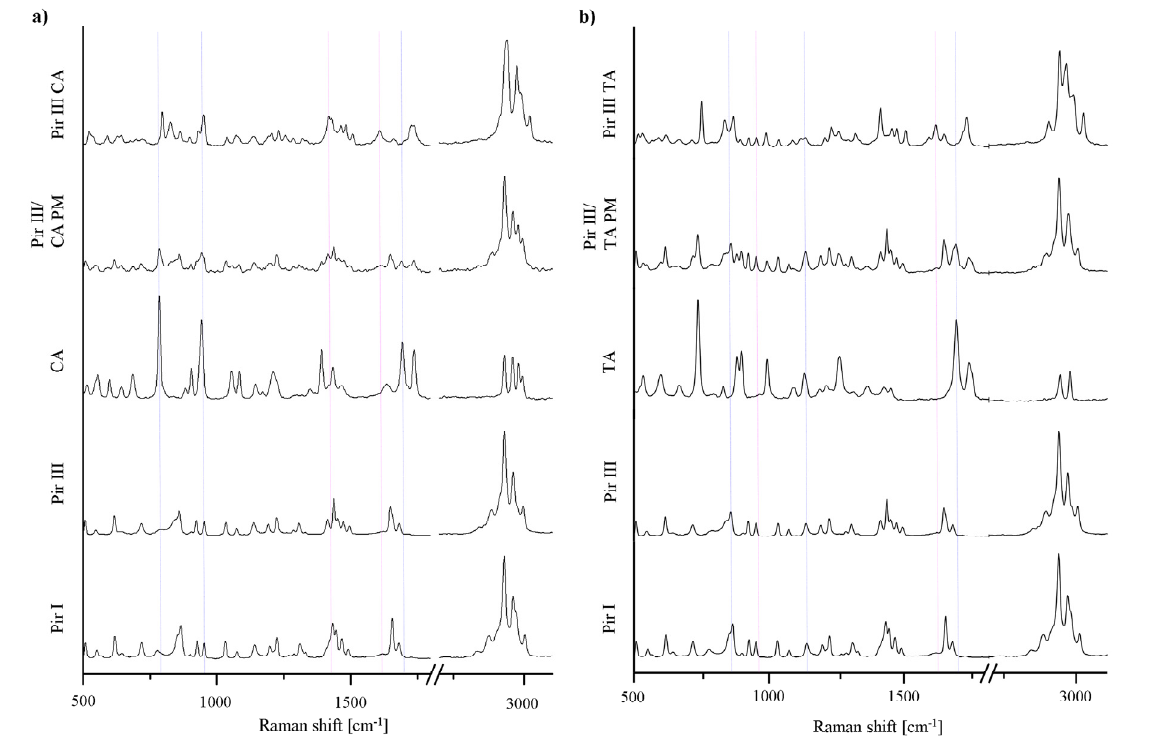
Figure 5. ( a ) Raman spectra of piracetam form I (Pir I) and form III (Pir III), citric acid (CA), physical mixture of piracetam form III and citric acid (Pir III/CA PM), and piracetam-citric acid cocrystal (Pir III CA). ( b ) Raman spectra of piracetam form I (Pir I) and form III (Pir III), tartaric acid (TA), physical mixture of piracetam form III and tartaric acid (Pir III/TA PM), and piracetam-tartaric acid cocrystal (Pir III